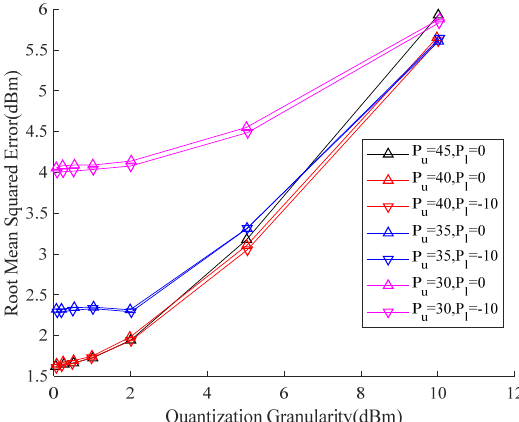
P , and CQI r , and specifically with Figure 8. RMSEs with different quantization parameters: u P Figure 8. RMSEs with different quantization parameters: P u , P (cid:96) , and r CQI , and specifically with ,  consideration to some combinations of P u = 45,40,35,30 dBm and quantization granularity consideration to some combinations of 45,40,35,30 P = dBm and quantization granularity ( u ( r CQI = 0.1, 0.2, 0.5, 1, 2, 5, 10 dBm). 0.1, 0.2, 0.5,1, 2, 5,10 = r dBm). CQI